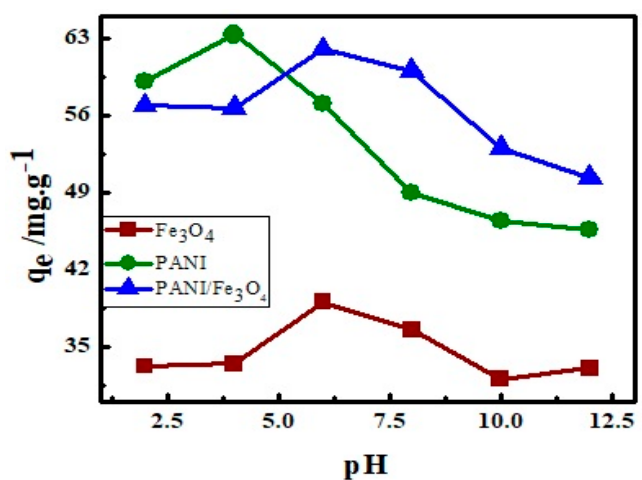
Figure 8. The e ff ect of solution pH on adsorption of AB40 on PANI, Fe 3 O 4 and PANI / Fe 3 O 4 composite. Figure 8. The effect of solution pH on adsorption of AB40 on PANI, Fe 3 O 4 and PANI/Fe 3 O 4 composite.